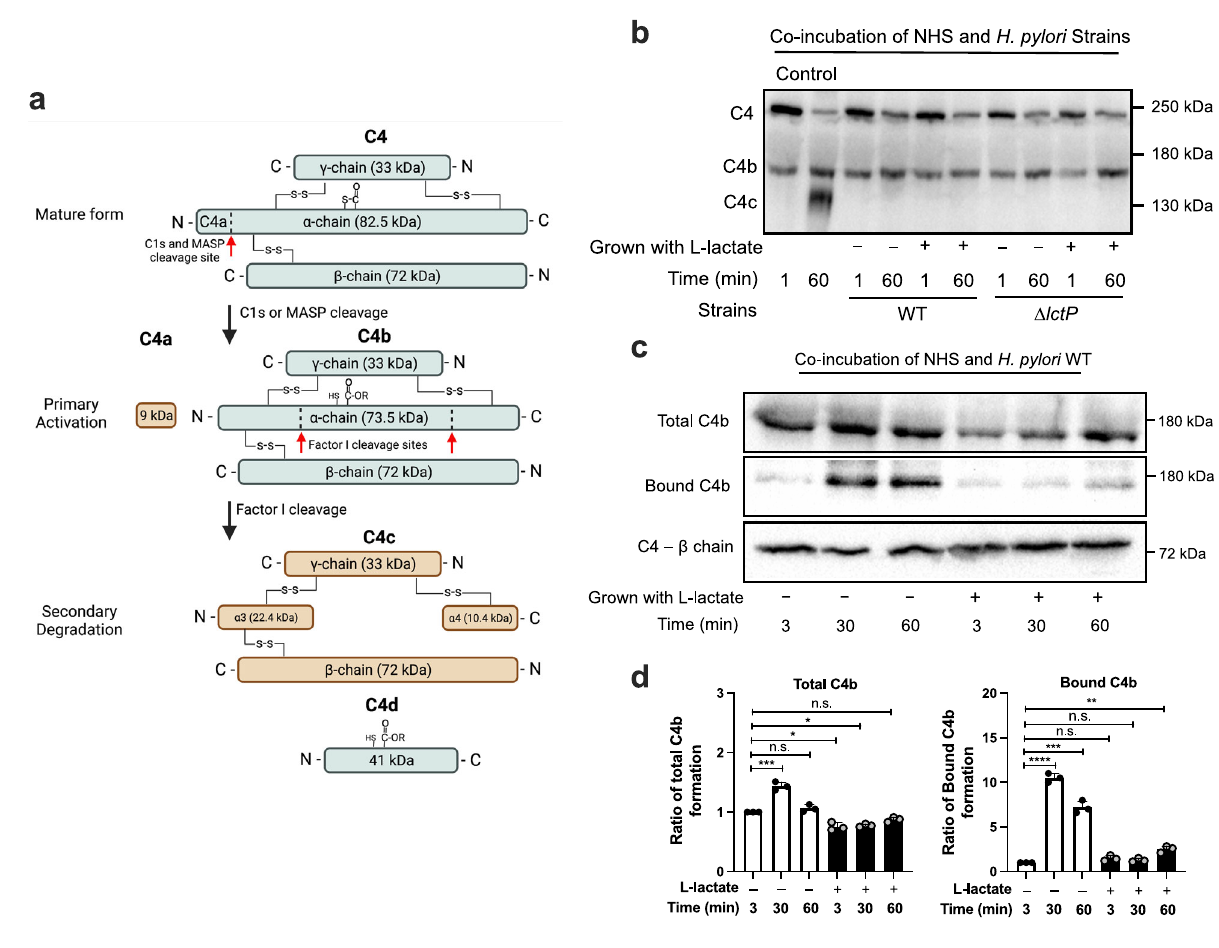
the reducing agent beta-mercaptoethanol (BME) (C4 β -chain). All protein samples were run on 5-7% SDS PAGE and blotted with anti-C4 antibody. d Quanti fi cation of the experiment shown in (c), from three independent experiments. Bands were quanti fi ed by normalizing each band to the amount of total C4b or bound C4b at 3min (leftmost band in each treatment group) using the Bio-Rad Image Lab soft- ware. Each point represents a biological sample for an independent experiment. The datawerecombined from the three independentexperiments (represented as mean±SD). The p values were obtained from unpaired two-tailed t -tests. The sig- ni fi cance is indicated as * ( p <0.05), *** ( p <0.001), **** ( p <0.0001), or n.s. (not signi fi cant). Source data and exact p- values are provided in the Source Data fi